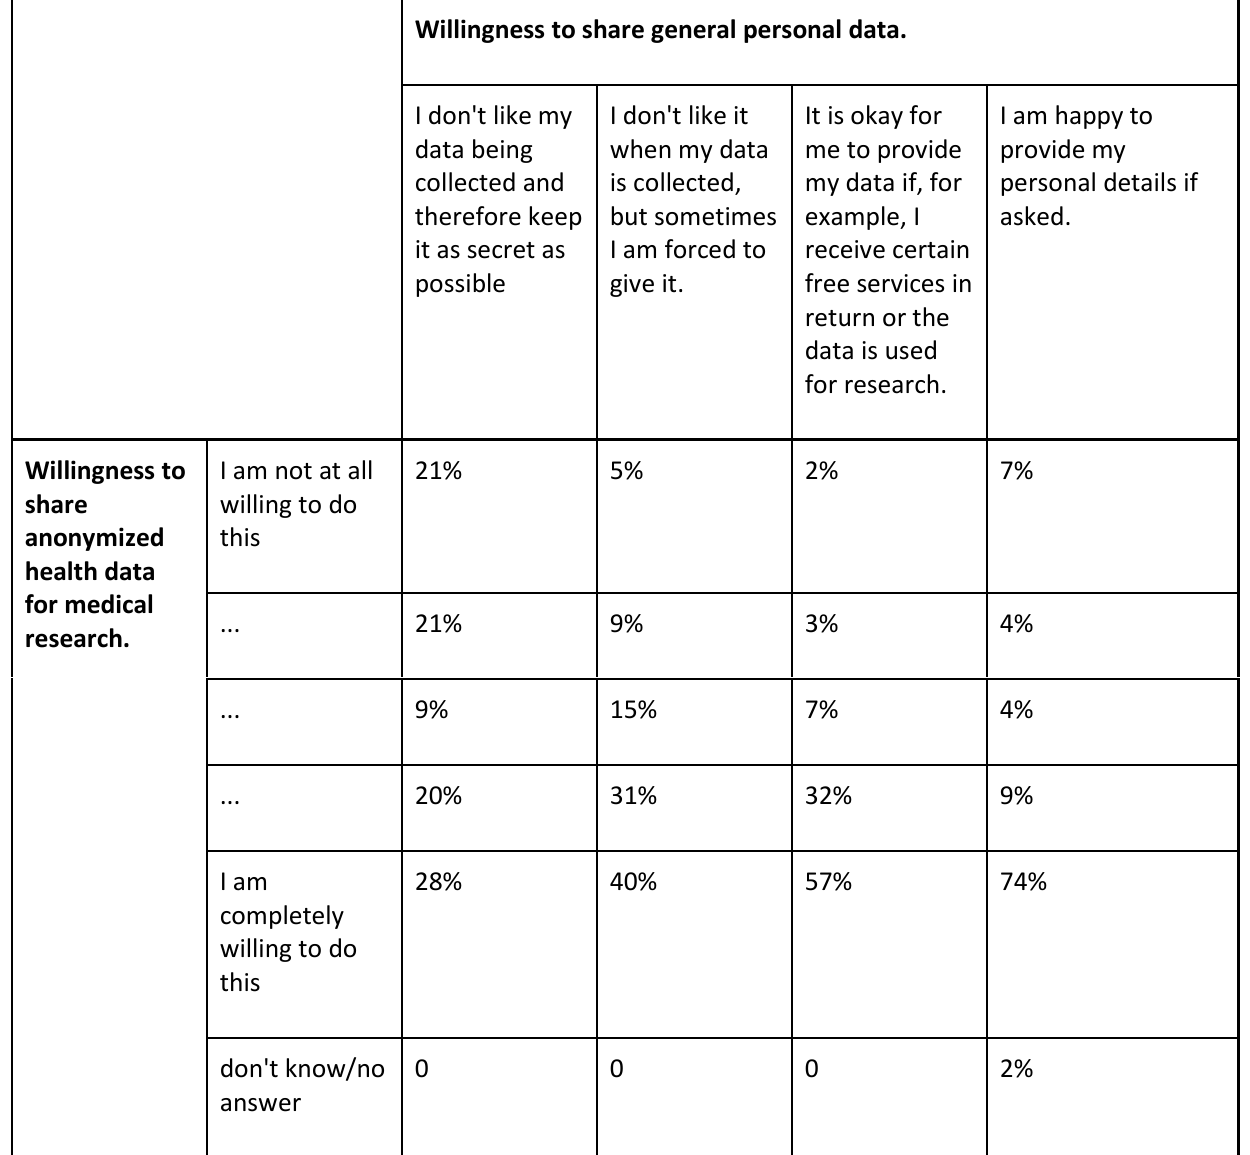
Table of general data vs anonymized health data